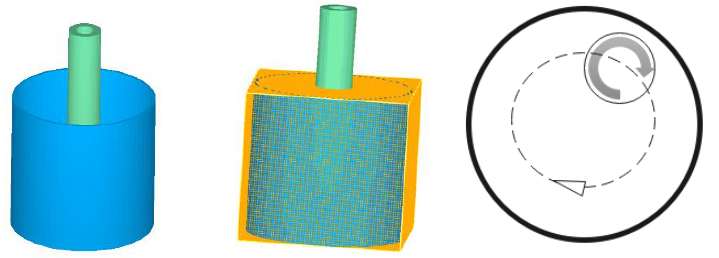
Figure 2. Three-dimensional model, meshing, and mixing operation diagram for simulation.